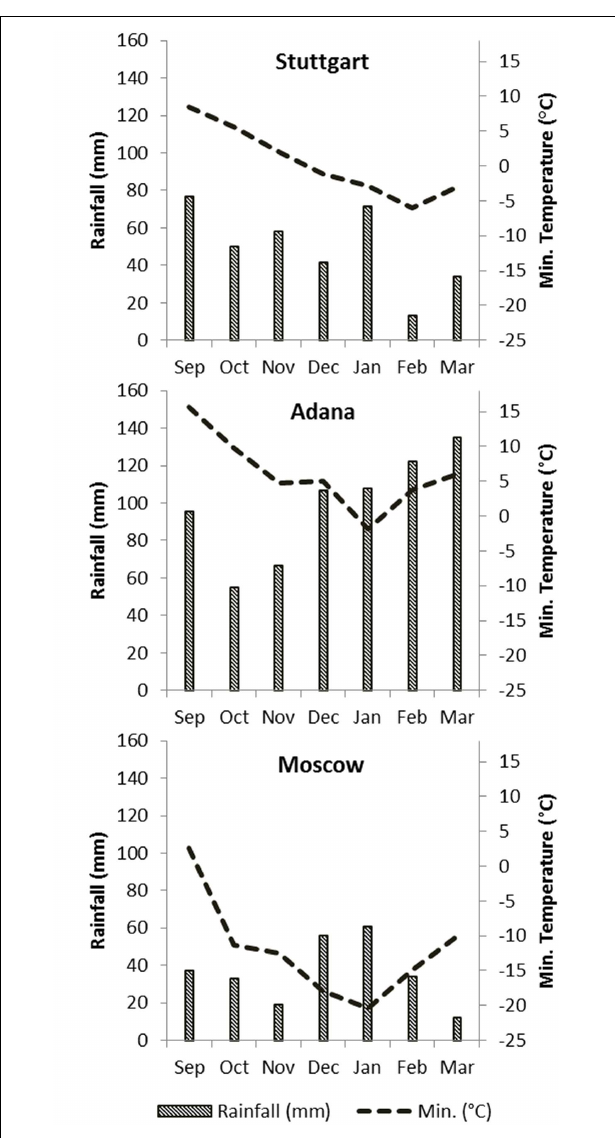
FIGURE 1 | Monthly rainfall (mm) and minimum air temperature ( ◦ C) for each site from September (2014) to March (2015), including irrigation in